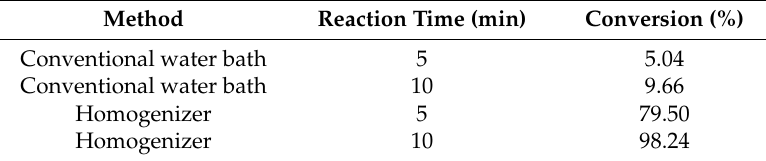
Table 3. Influence of conventional heating (water bath) and homogenizer on conversion